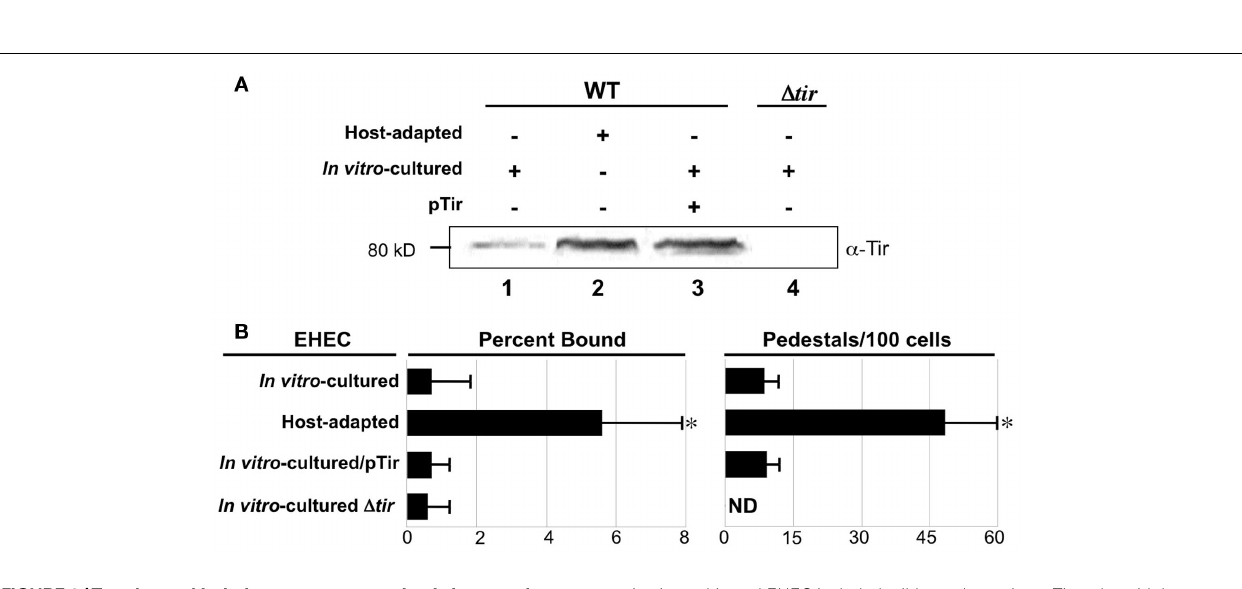
FIGURE 3 |Translocated intimin receptor expression is increased during host adaptation but is not solely responsible for enhanced pedestal formation . (A) Equivalent numbers of bacteria were utilized to generate bacterial lysates of host-adapted or in vitro -cultivated EHEC that were subjected to immunoblotting using anti-intimin antibody.The